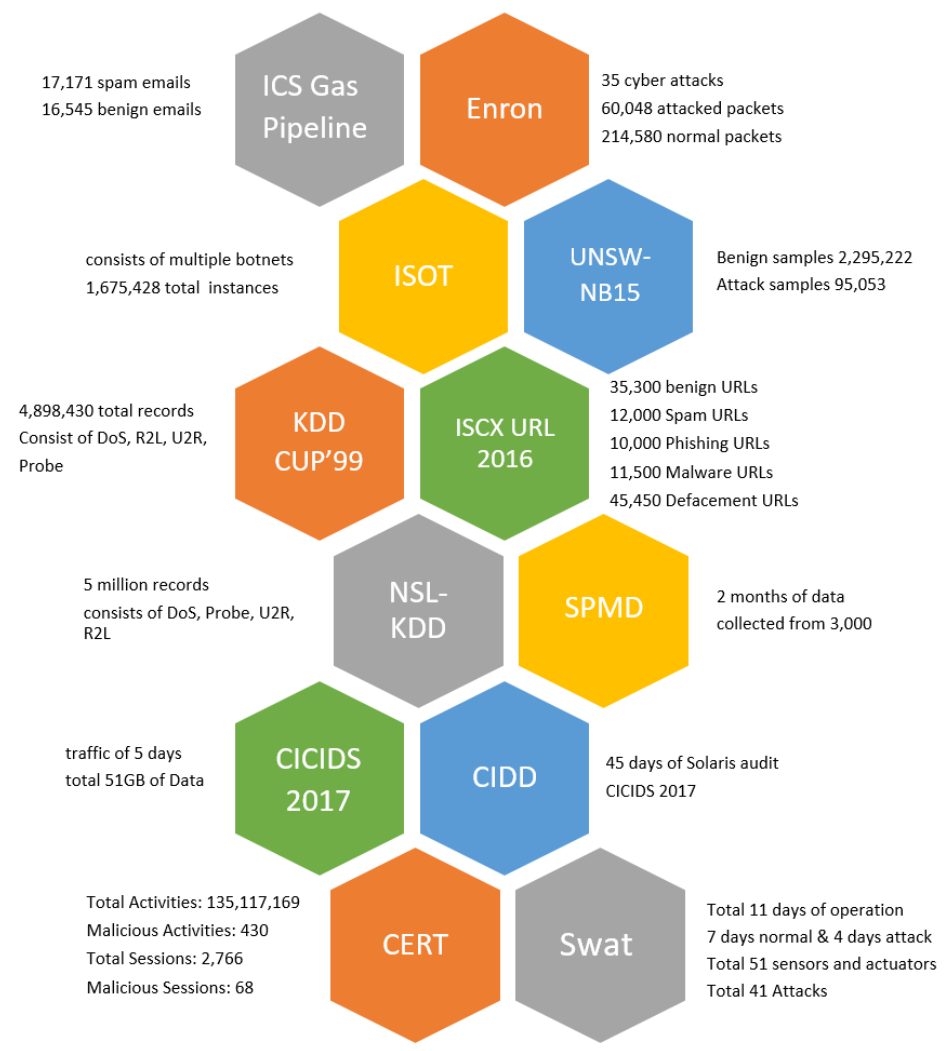
Figure 4. Datasets used in the comparative